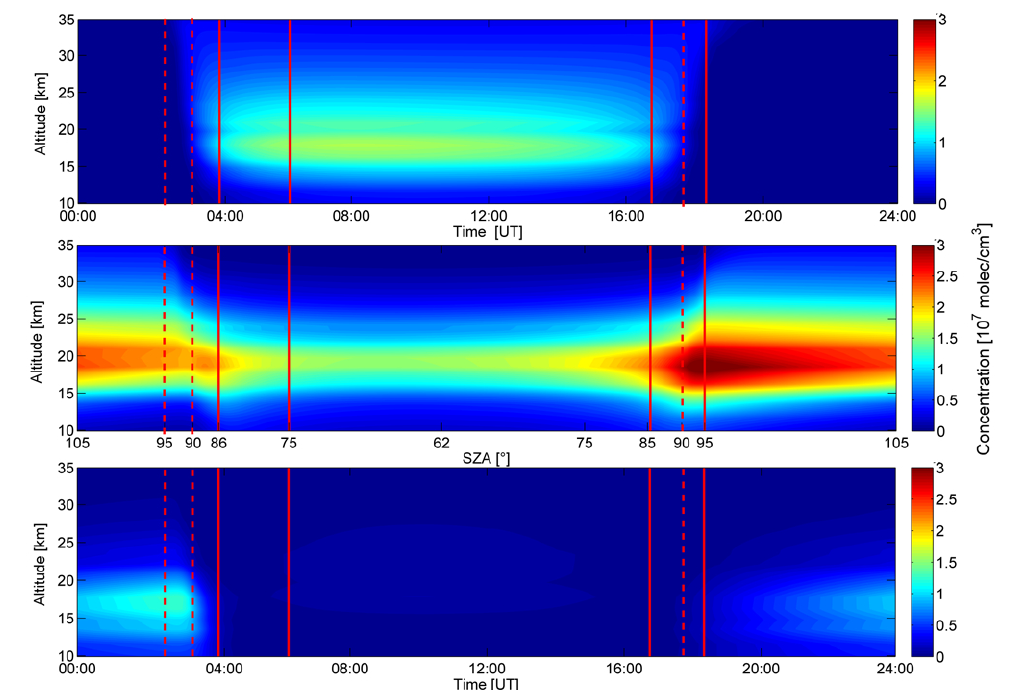
Fig. 3. Standard simulation of the key stratospheric bromine species for 7 September 2009 using the Labmos photochemical model: diurnal variation of BrO (upper panel), BrONO 2 (middle panel), and HOBr (lower panel). The red lines indicate the periods of the limb measure- ments (local SZA at the balloon gondola = 86–75 ◦ at a.m. and 85–95 ◦ at p.m.) and the dashed red lines the period of the direct sunlight measurements (local SZA = 95–90 ◦ at a.m., and SZA = 90–95 ◦ at p.m.). Solar zenith angles shown in the middle panel refer to the SZA at the balloon location, and the colour coding indicates the respective concentrations in units of 10 7 moleccm − 3